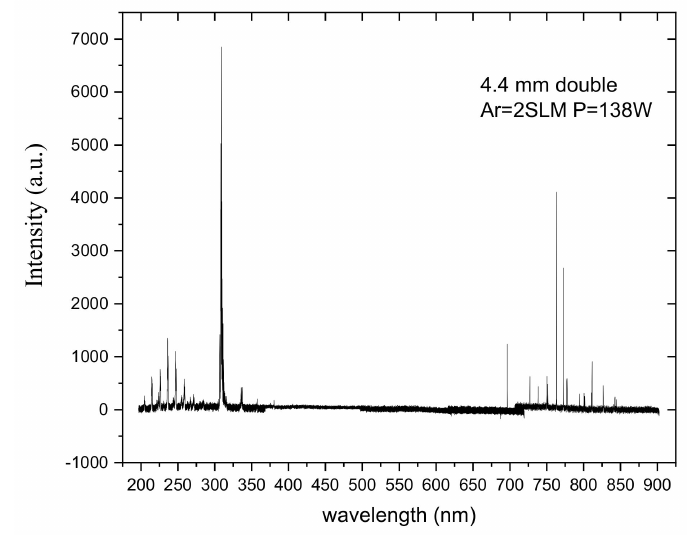
Figure 9. Emission spectra of plasma at 138